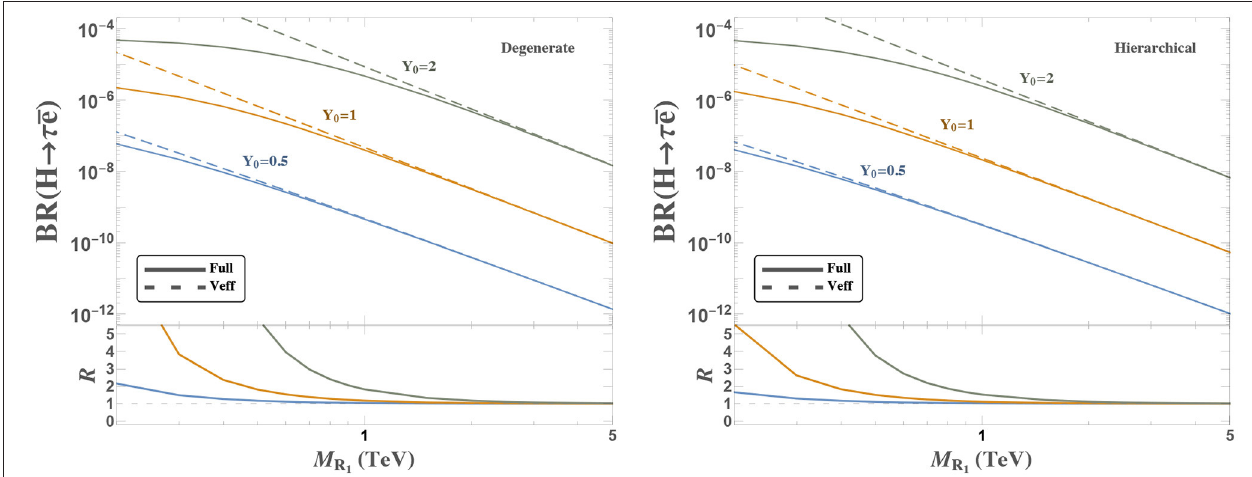
e ) using the exact computation (solid lines) and the effective vertex in Equation (28) (dashed lines). The ratio R τ ¯ →